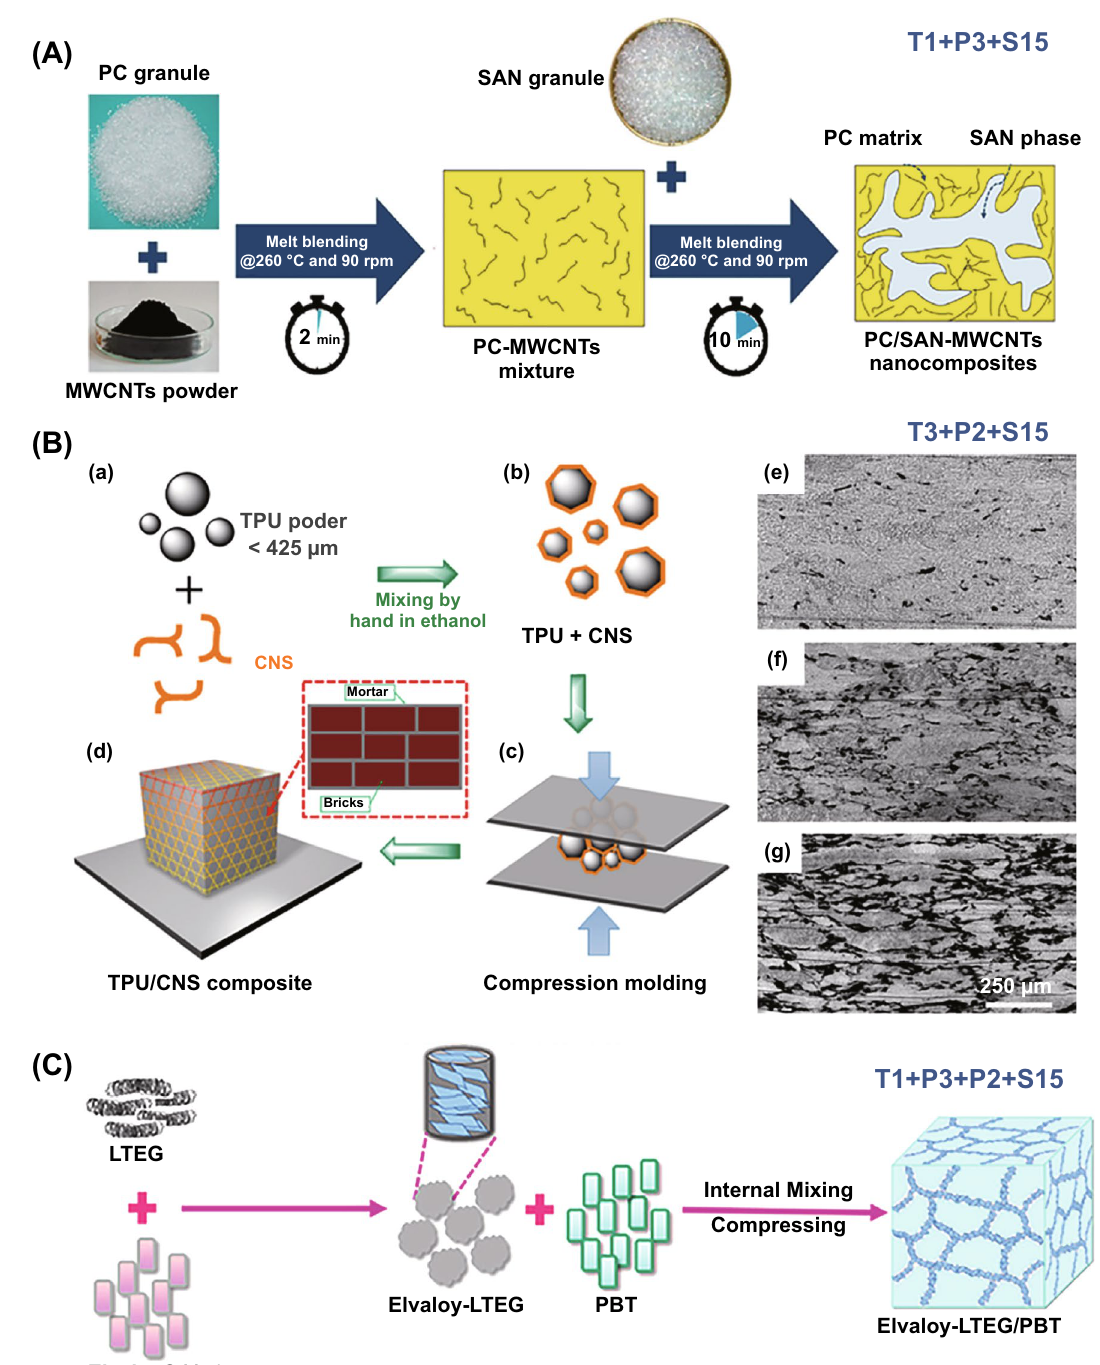
Fig. 14 A Schematic plot of the fabrication for PC/SAN(polycarbonate/PS-co-acrylonitrile)/MWCNTs composites. Reprinted with permission from Ref. [192]. B Sketch of the preparation procedure and characterization of thermoplastic polyurethane carbon nanostructures (TPU/CNS) composites with segregated CNS network structure. Reprinted with permission from Ref. [199]. C Schematic of the preparation procedure for Elvaloy@4170 low-temperature expandable graphite/poly(butylene terephthalate) (LTEG/PBT) composites with segregated network. Reprinted with permission from Ref.